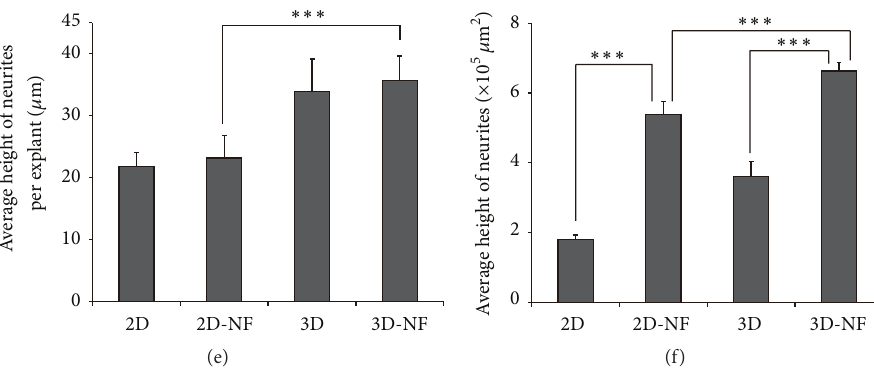
Figure 8: Synergistic influence of matrigel with BDNF and NT3 on neurite outgrowth. (a) The diagram of the assay. (b) Representative staining of neurites observed on SGN explants treated with 2D 2D-NF, 3D, and 3D-NF. DAPI (blue), 𝛽 -tubulin (green). (c–f) Quantifications of the average number, length, height, and area of neurites in treated groups. ∗ 𝑝 < 0.05 , ∗∗ 𝑝 < 0.01 , and ∗∗∗ 𝑝 < 0.001